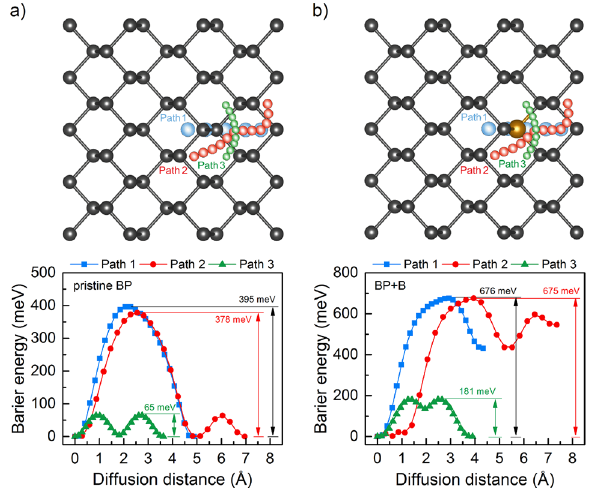
Figure 7. Three possible Mg ion migration paths over pristine ( a ) and B-doped ( b ) phosphorene.